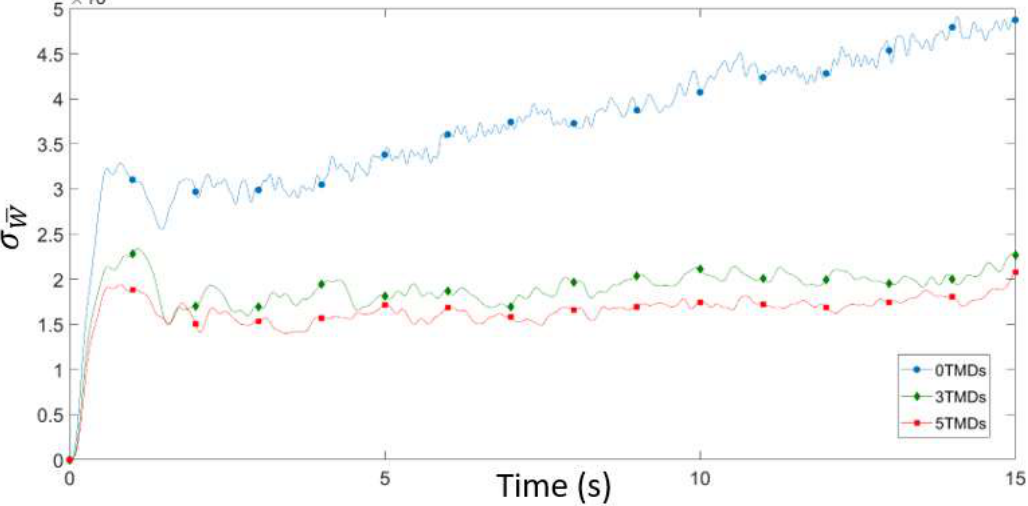
Figure 2. Standard deviation of displacement.